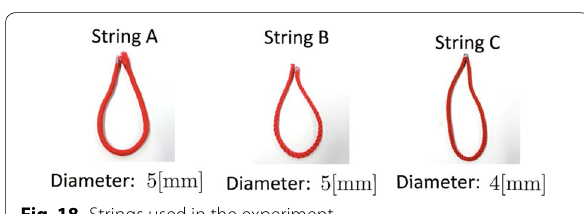
Fig. 18 Strings used in the